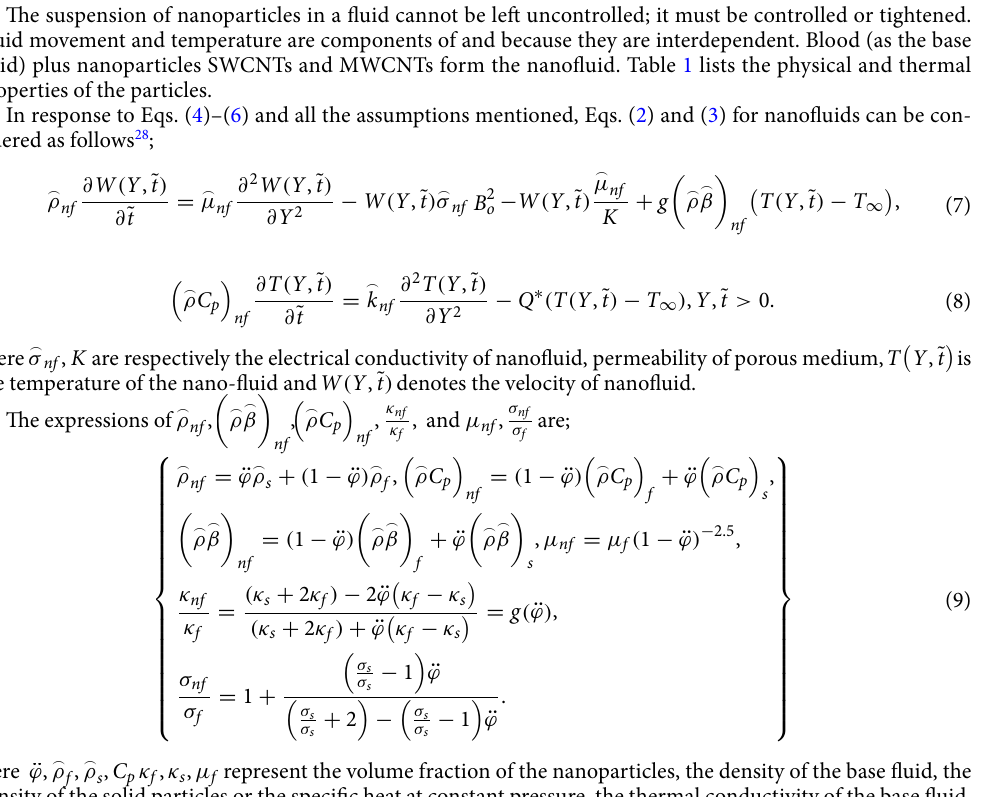
and utilization of Ohm’s law that lead to,